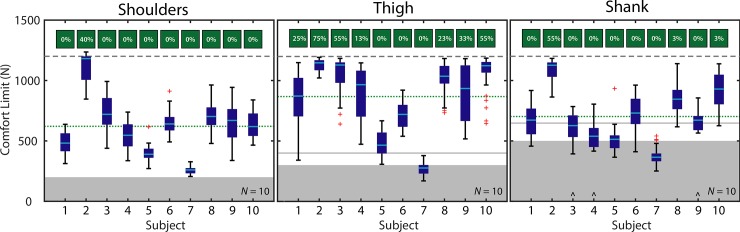
Inter-subject comfort limits.Boxplots depict individual subject results. Boxplots indicate subject median (cyan line), 25th and 75th quartiles (dark blue box), whiskers (extending to the farthest data point or 1.5x the interquartile range, whichever is nearer the median) and outliers (red cross markings). Three subjects (denoted with ^) only completed the first two sessions of testing on the shank. Percentage of trials that reached the maximum approved force limit are depicted in green boxes above each column. The 1200 N maximum approved force limit is denoted with a dashed gray line. The group mean comfort limit is denoted with a dotted green line. The gray boxes indicate the approximate range of forces applied by exosuits in prior literature during dynamic tasks [1], [2], [14–16]; the gray solid lines indicate maximum peak forces applied by individual studies during static tasks [4], [13].